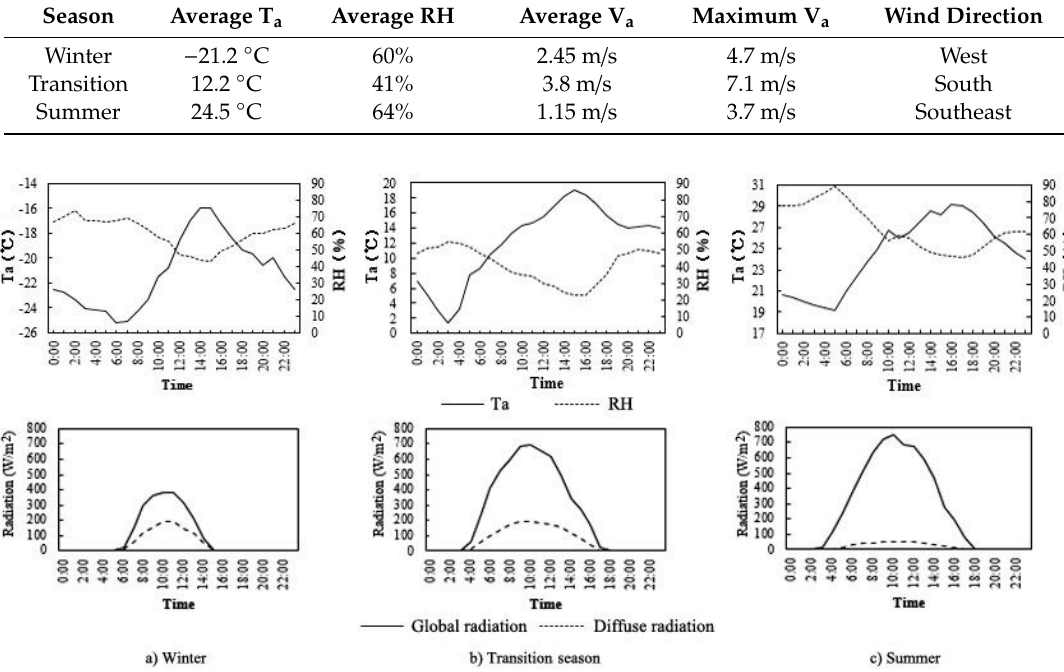
Figure 5. Diurnal variation of T a , RH, and solar radiation of the measured days in different seasons.